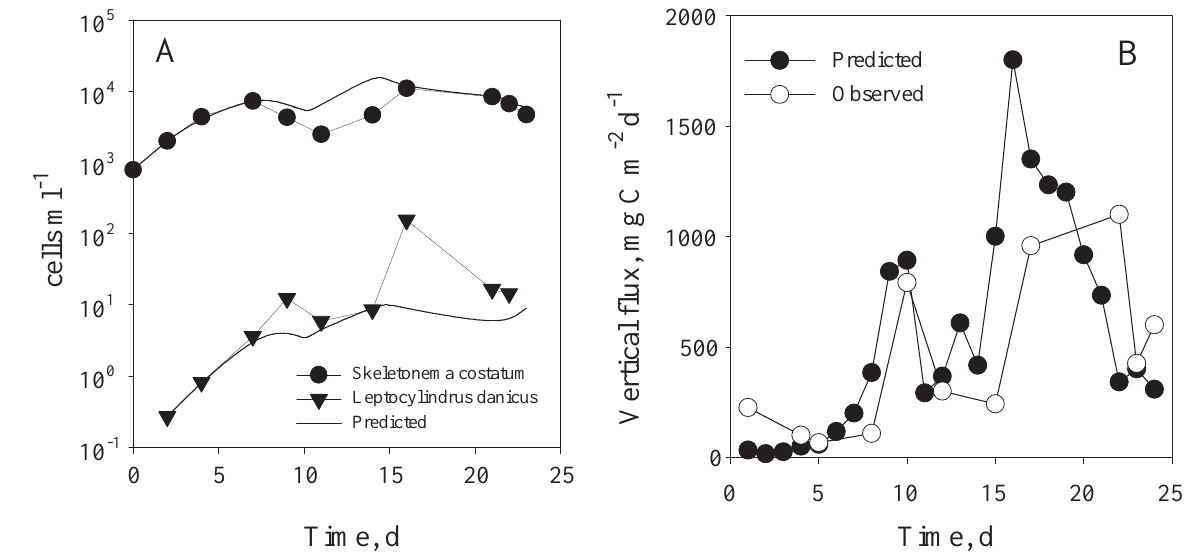
F IG . 3. – Observed and predicted temporal variation in the population sizes of two species of diatoms (A) and in the vertical flux of phyto- plankton (B) in a Danish fjord. Predictions were made using eq. 1 and observations of phytoplankton growth rate, stickiness and ambient fluid shear as well as phytoplankton concentration and sizes. Data from Kiørboe et al. (1994) and Hansen et al.